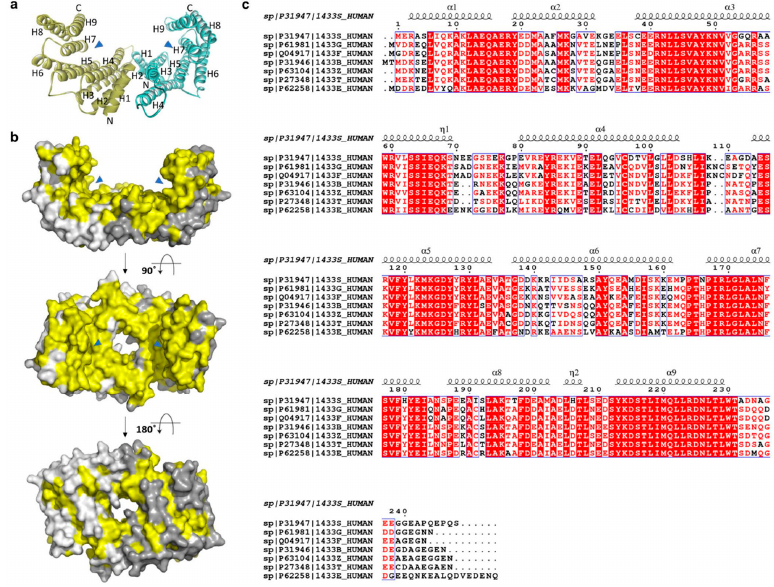
Figure 2. ( a ) Ribbon and ( b ) surface representations of the 14-3-3 σ homodimer (PDB: 1YZ5 and 1YWT, respectively). The amphipathic binding grooves are indicated by blue triangles while the conserved residues are highlighted in yellow color. The second and third structures are rotated 90° and 180°, respectively, around the x -axis from the previous structure. ( c ) Sequence alignment of the seven human 14-3-3 isoforms (UniProtKB codes, h14-3-3 ɛ : P62258; h14-3-3 σ : P31947; h14-3-3 γ : P61981; h14-3-3 η : Q04917; h14-3-3 τ : P27348; h14-3-3 ζ : P63104; h14-3-3 β : P31946), as performed with ClustalW and ESPript 3.0, with red box, white character: strict identity; red character: similarity in group; blue frame: similarity across group. The α -helical regions are indicated above the sequence. In the case of 14-3-3 σ , major non-conserved amino acid residues (Ser5, Glu20, Phe25, Gln55, and Glu80) are located at the interface between both monomers near the N-terminus of the 14-3-3 σ isoform. Among them, the residues Ser5, Glu20, Phe25, and Glu80 together with the highly conserved hydrophobic core residues located at the dimer interface, i.e., Leu12 and Tyr84, were found to play a crucial rule in the stabilization of the homodimer molecule and maintaining the full dimerization activity of 14-3-3 σ (Figure 3) [53,58]. This is evidenced by the dissociation of the dimeric 14-3-3 σ into monomers with diminished function upon mutation of these residues [53,58,59].